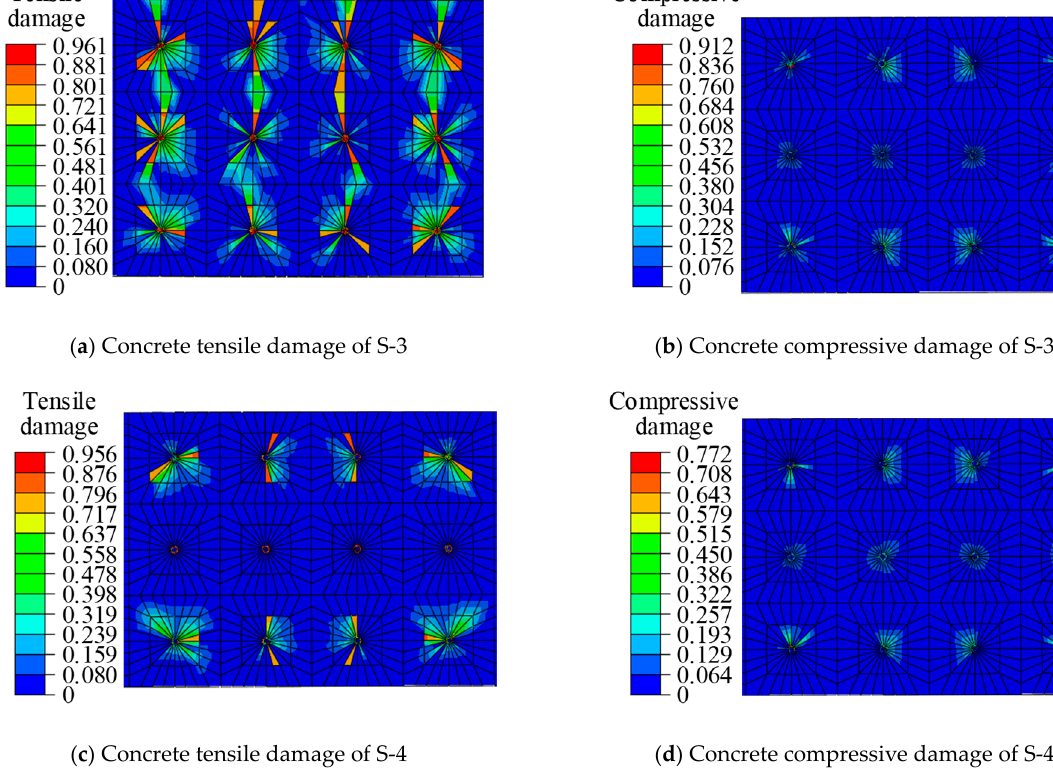
Figure 17. Concrete damage of S-3 and S-4.